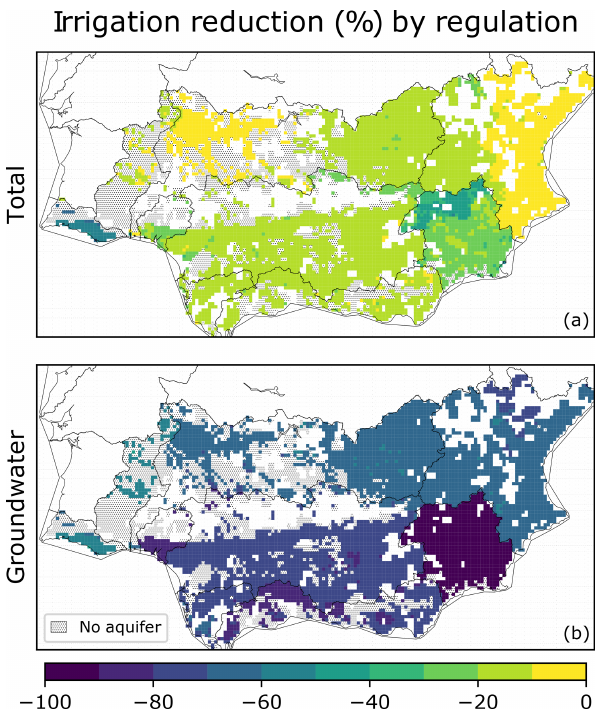
Figure 7. Irrigation reduction simulated by restricting groundwater abstraction to sustainable levels in the southern Iberian Peninsula, as compared to unrestricted conditions: (a) total abstractions from surface water and groundwater, and (b) from groundwater only. Dis- played reductions are 1990–2018